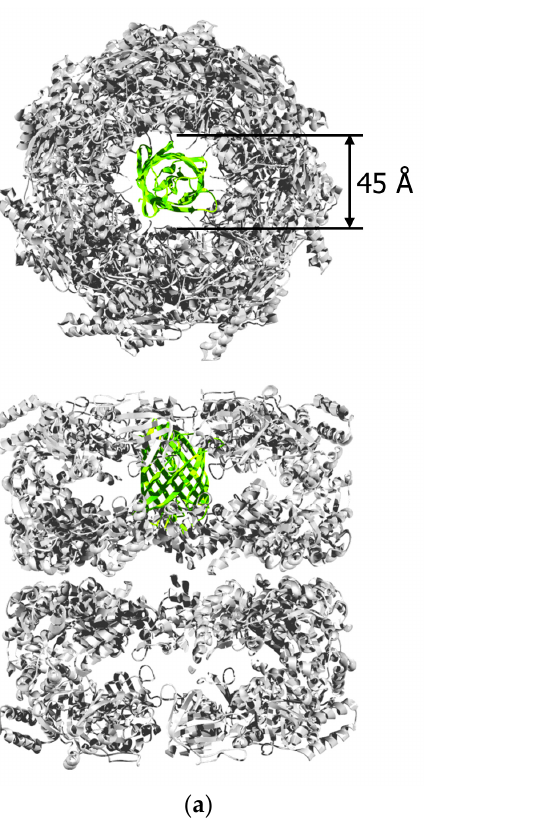
Figure 8. A model of GroEL 14 with EGFP incorporated into the inner cavity of one of the protein rings. ( a ) Ribbon view from top and side with three front subunits deleted; ( b ) space-fill view from top and side with three front subunits deleted. GroEL is in gray, and EGFP is in green. Structures used in modeling are from PDB ID 1OEL for GroEL [38] and PDB ID 2Y0G for EGFP [39]; the presentation was composed using SPDBViewer 4.1.0 software (developed by Nicolas Guex, Geneva, Switzerland) [40], and POV-Ray 3.7.0 software (Persistence of Vision Raytracer Pty. Ltd., Williamstown, Victoria, Australia).